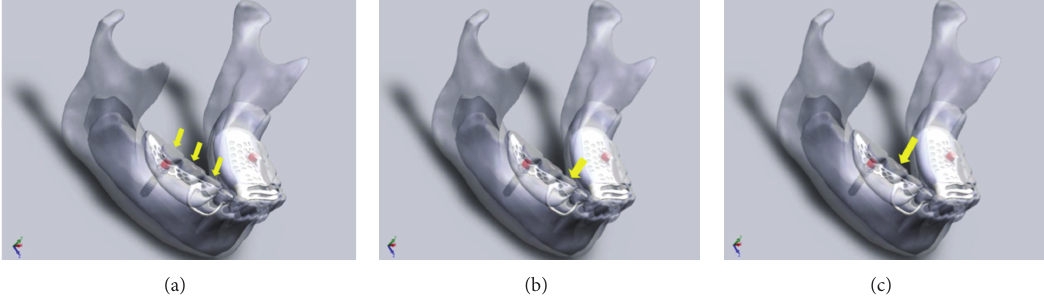
Figure 3: (a) Unilateral loading uniform; (b) unilateral loading premolar; (c) unilateral loading